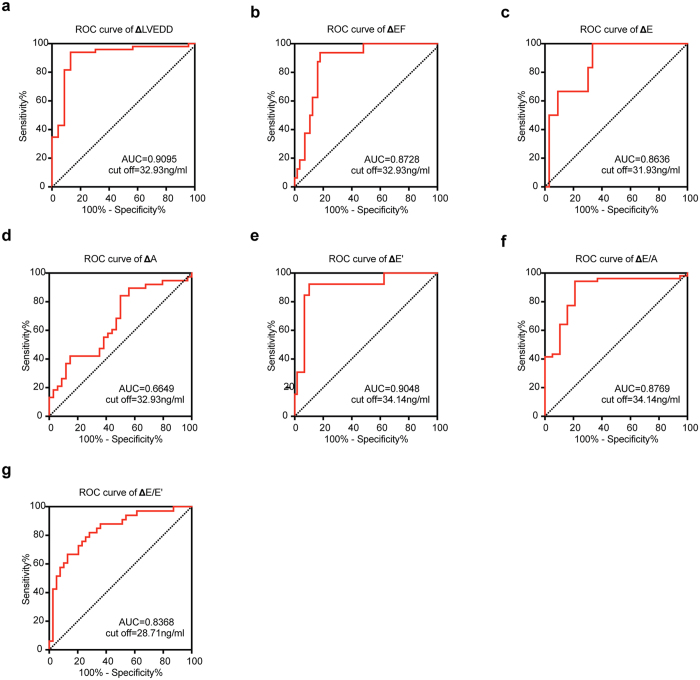
(a–g) Receiver operating characteristic curves (ROC) showing the ability of catestatin at D3 to predict echocardiography parameter changes. Specificity as well as sensitivity was determined. The diagonal was shown in each diagram.